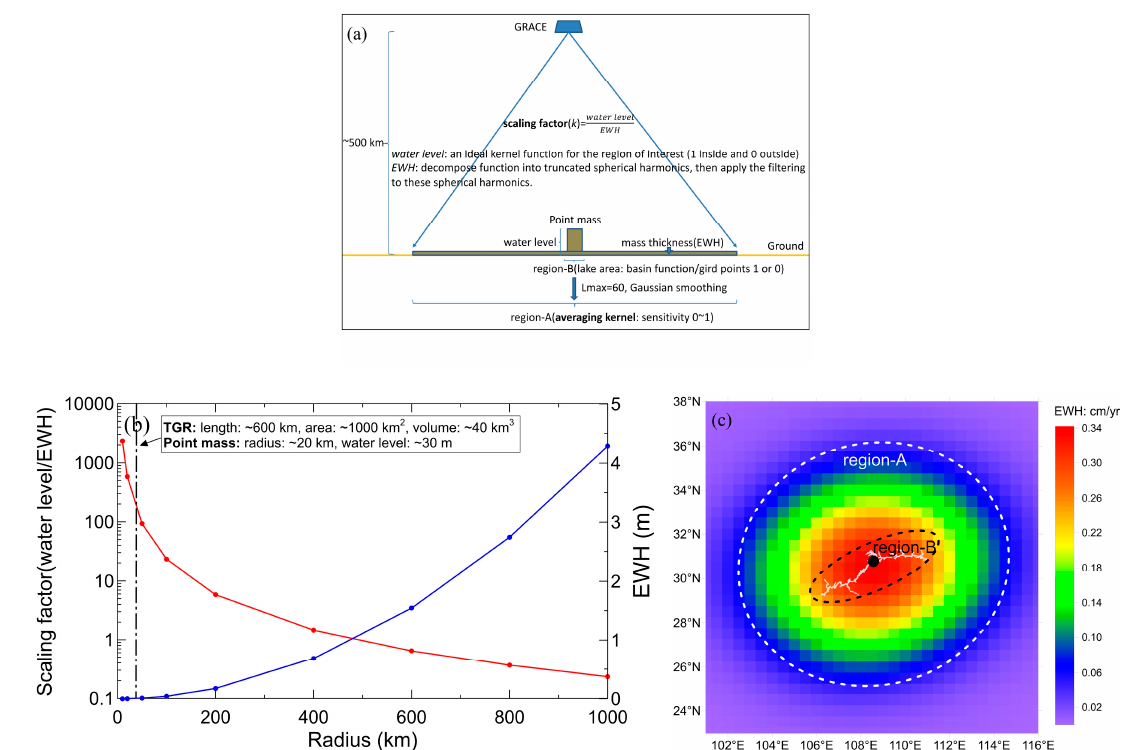
Figure 9. ( a ) Schematic diagram showing usage of the averaging function to restore realistic mass changes in GRACE results. ( b ) EWH scaling factor changes for different smoothing radii. ( c ) Trends in the TGR prediction after truncation to degree 60 and application of a 350 km Gaussian filter. The dashed white circle shows region-A and the black dot shows region-B.